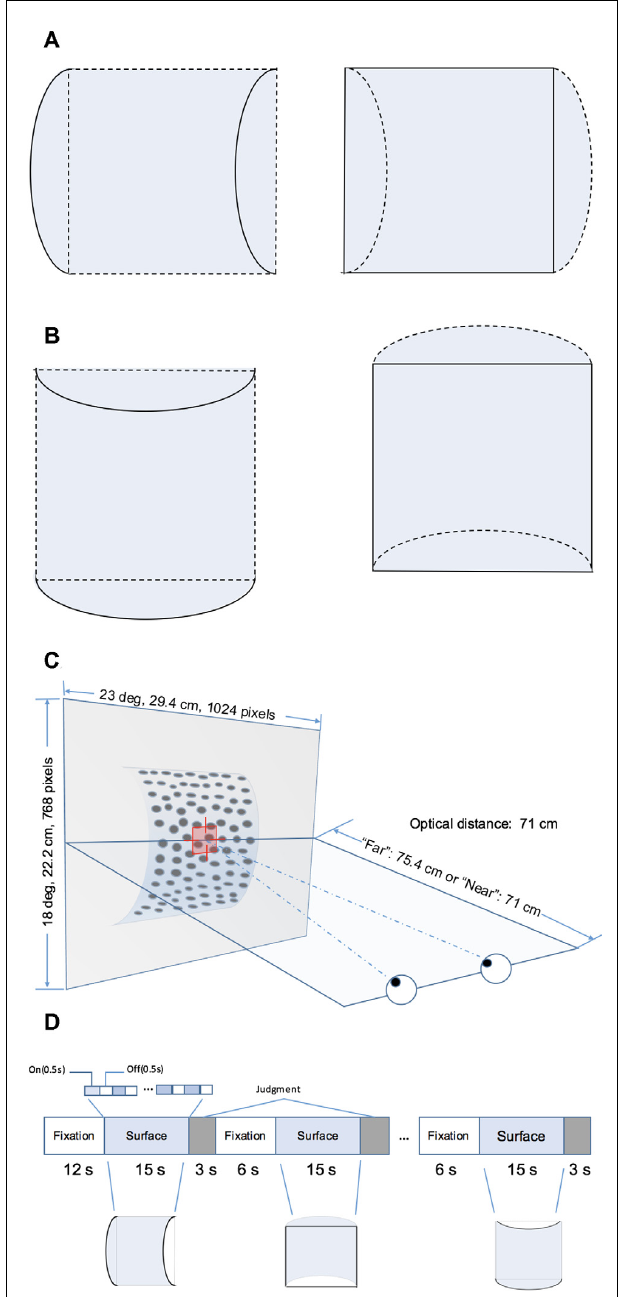
FIGURE 1 | Schematic illustration of the stimuli and block design. (A) Horizontal hemi-cylindrical convex (left) and concave (right) surfaces. (B) Vertical hemi-cylindrical convex (left) and concave (right) surfaces. (C) Experimental set up (the example is a convex near surface). (D) Illusion of the functional magnetic resonance imaging (fMRI) block design.